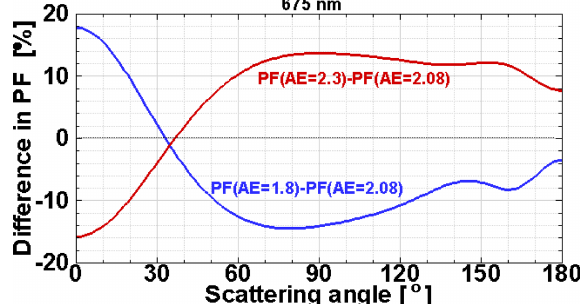
Figure 8. This figure shows how the aerosol phase function (PF) at 675nm changes when the AE is perturbed by ± 10% of the baseline value of